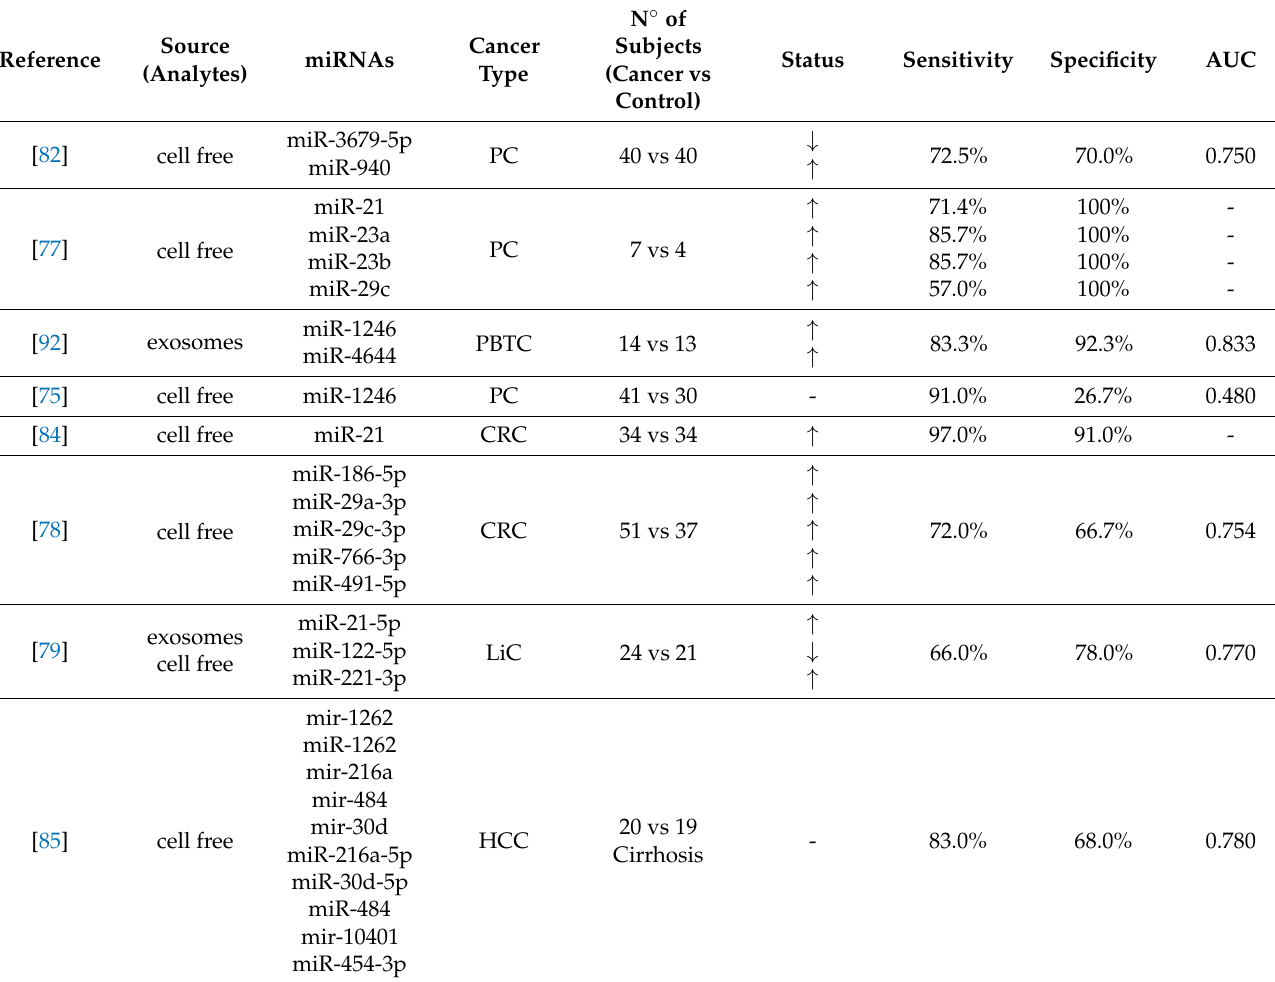
Table 1. Salivary miRNAs in oncological conditions. PC: pancreatic cancer, BPT: benign pancreatic tumor, PBTC: pancreatobiliary tract cancer, HS: Healthy subjects, CRC: colorectal cancer, LiC: liver cancer, HCC: epatocellular carcinoma, MPE: malignant pleural effusion, BC: breast cancer, GC: gastric cancer. Each row provides information regarding the citation in parenthesis at the far left end of the